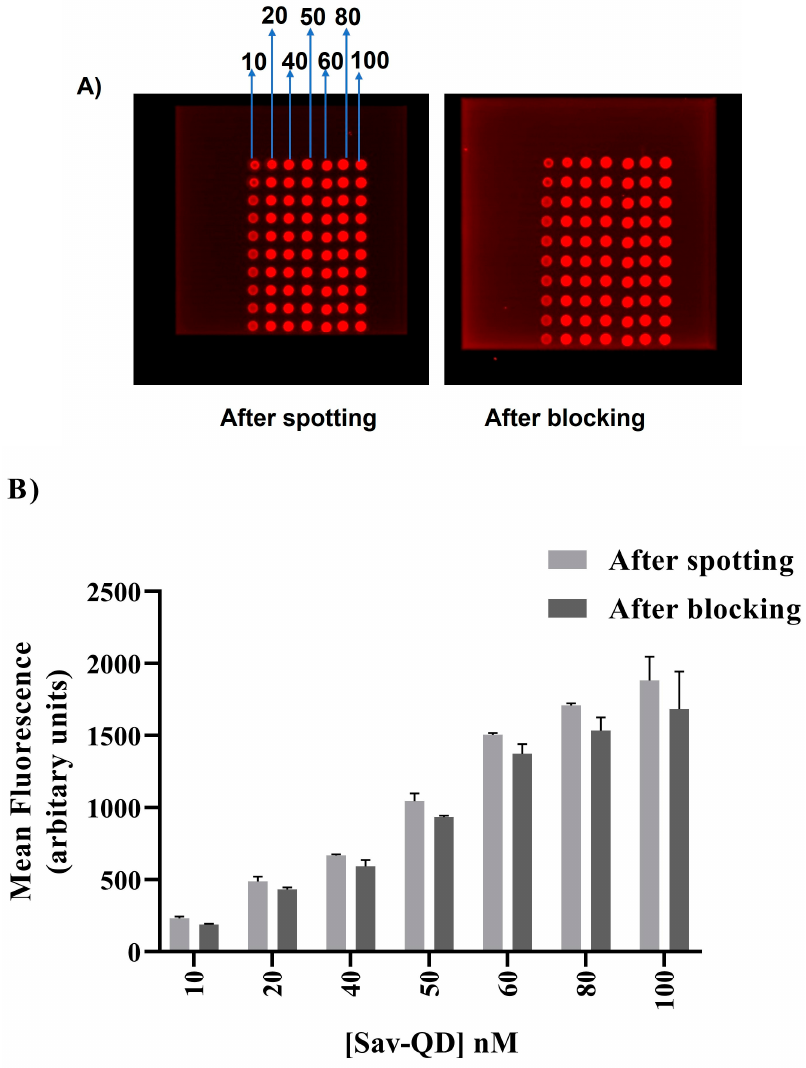
Figure 2. ( A ) Sav-QDs of 10, 20, 40, 50, 60, 80, and 100 nM concentrations which are spotted and blocked. ( B ) The fluorescence intensity of spotted Sav-QDs is concentration-dependent and the blocking buffer does not cause any significant reduction in the signal. The mean fluorescence signal (signal mean–background mean) is plotted against different concentrations of Sav-QDs.